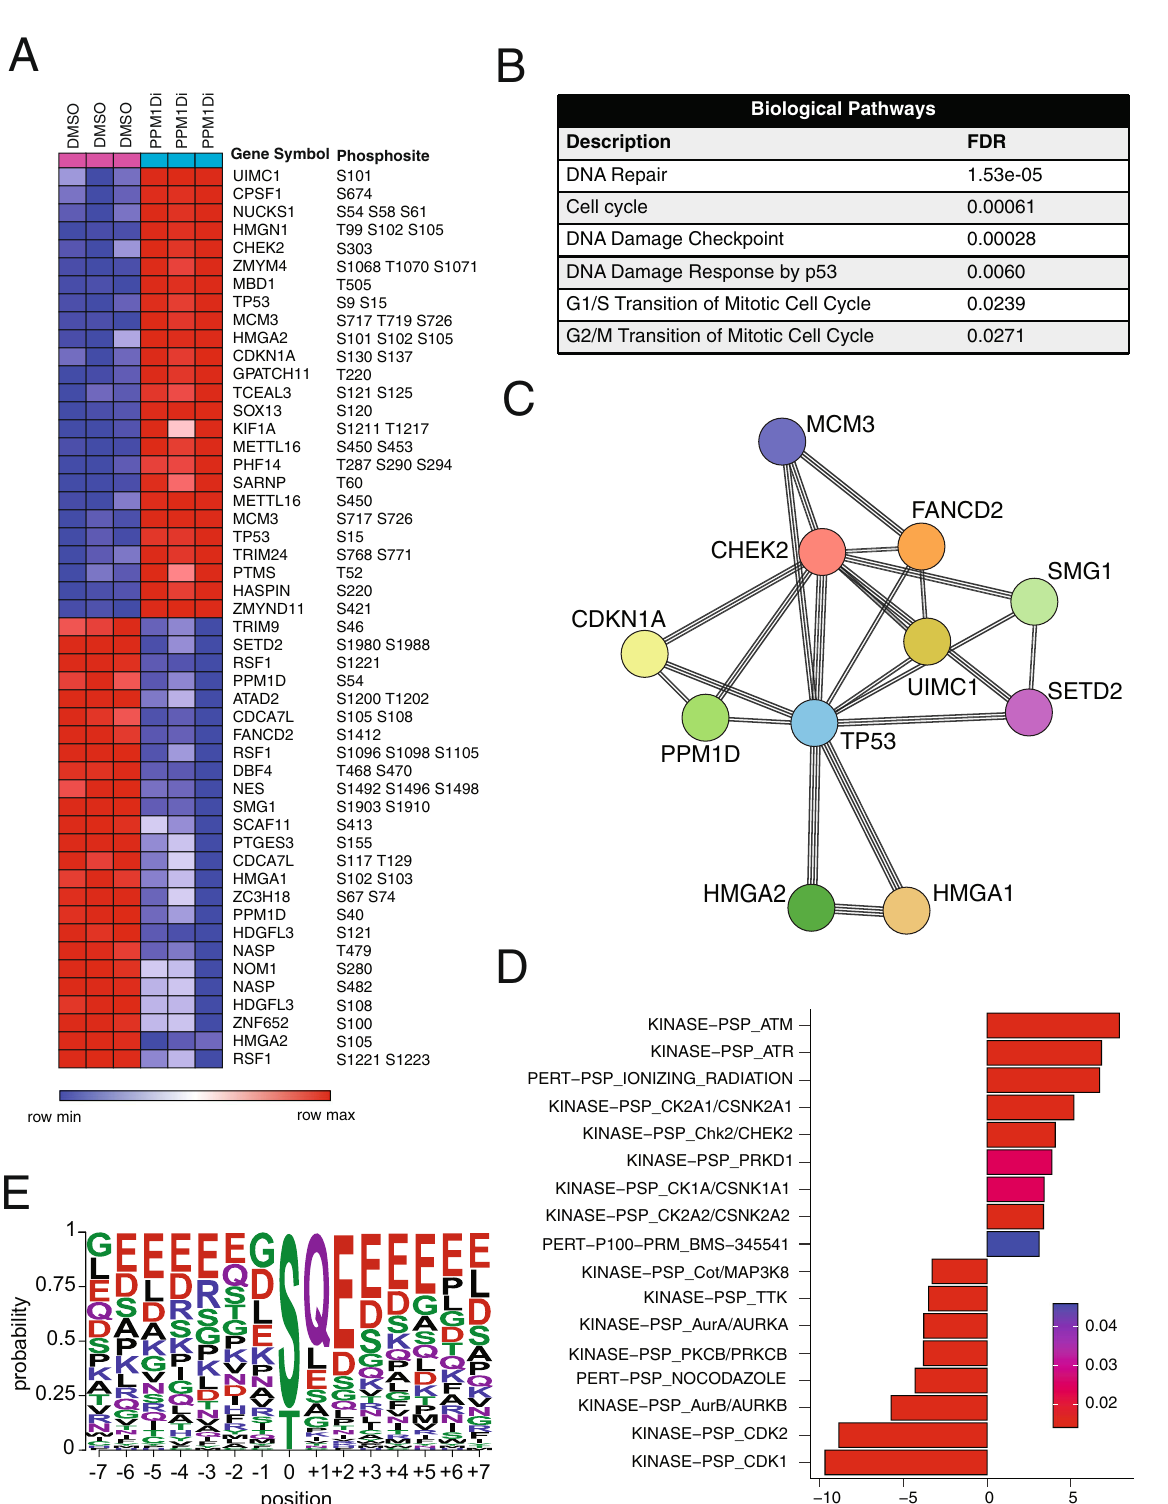
calculated pairwise Pearson correlations between PPM1D depen- dency and dependency on all other genes within the DepMap dataset (Fig. 6C) and found cell cycle checkpoint and TP53 - associated DNA repair genes to be most strongly associated with PPM1D dependency. Negative regulators of TP53 signaling and PPM1D substrates MDM2 and MDM4 were the top dependencies that correlated with PPM1D dependency (Fig. 6C and